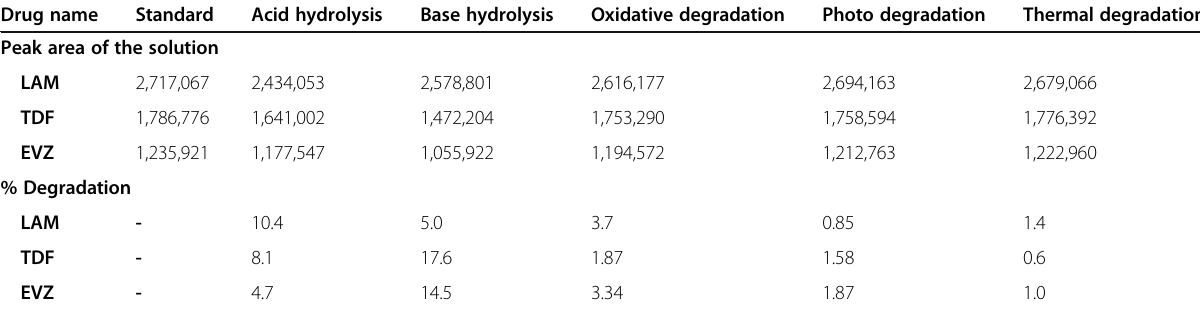
Table 7 Results of forced degradation studies